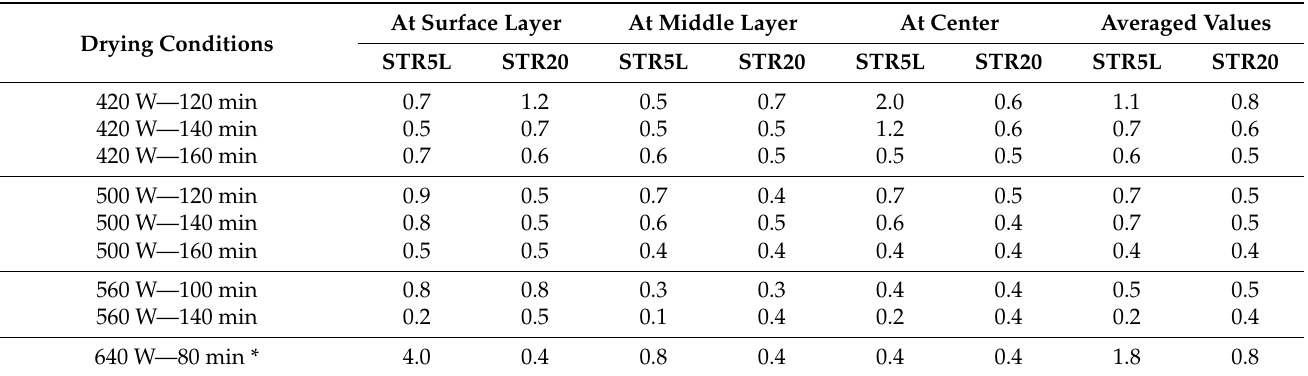
Table 5. The volatile content (percent by weight) of the dried STR5L and STR20 samples at differ- ent parts.